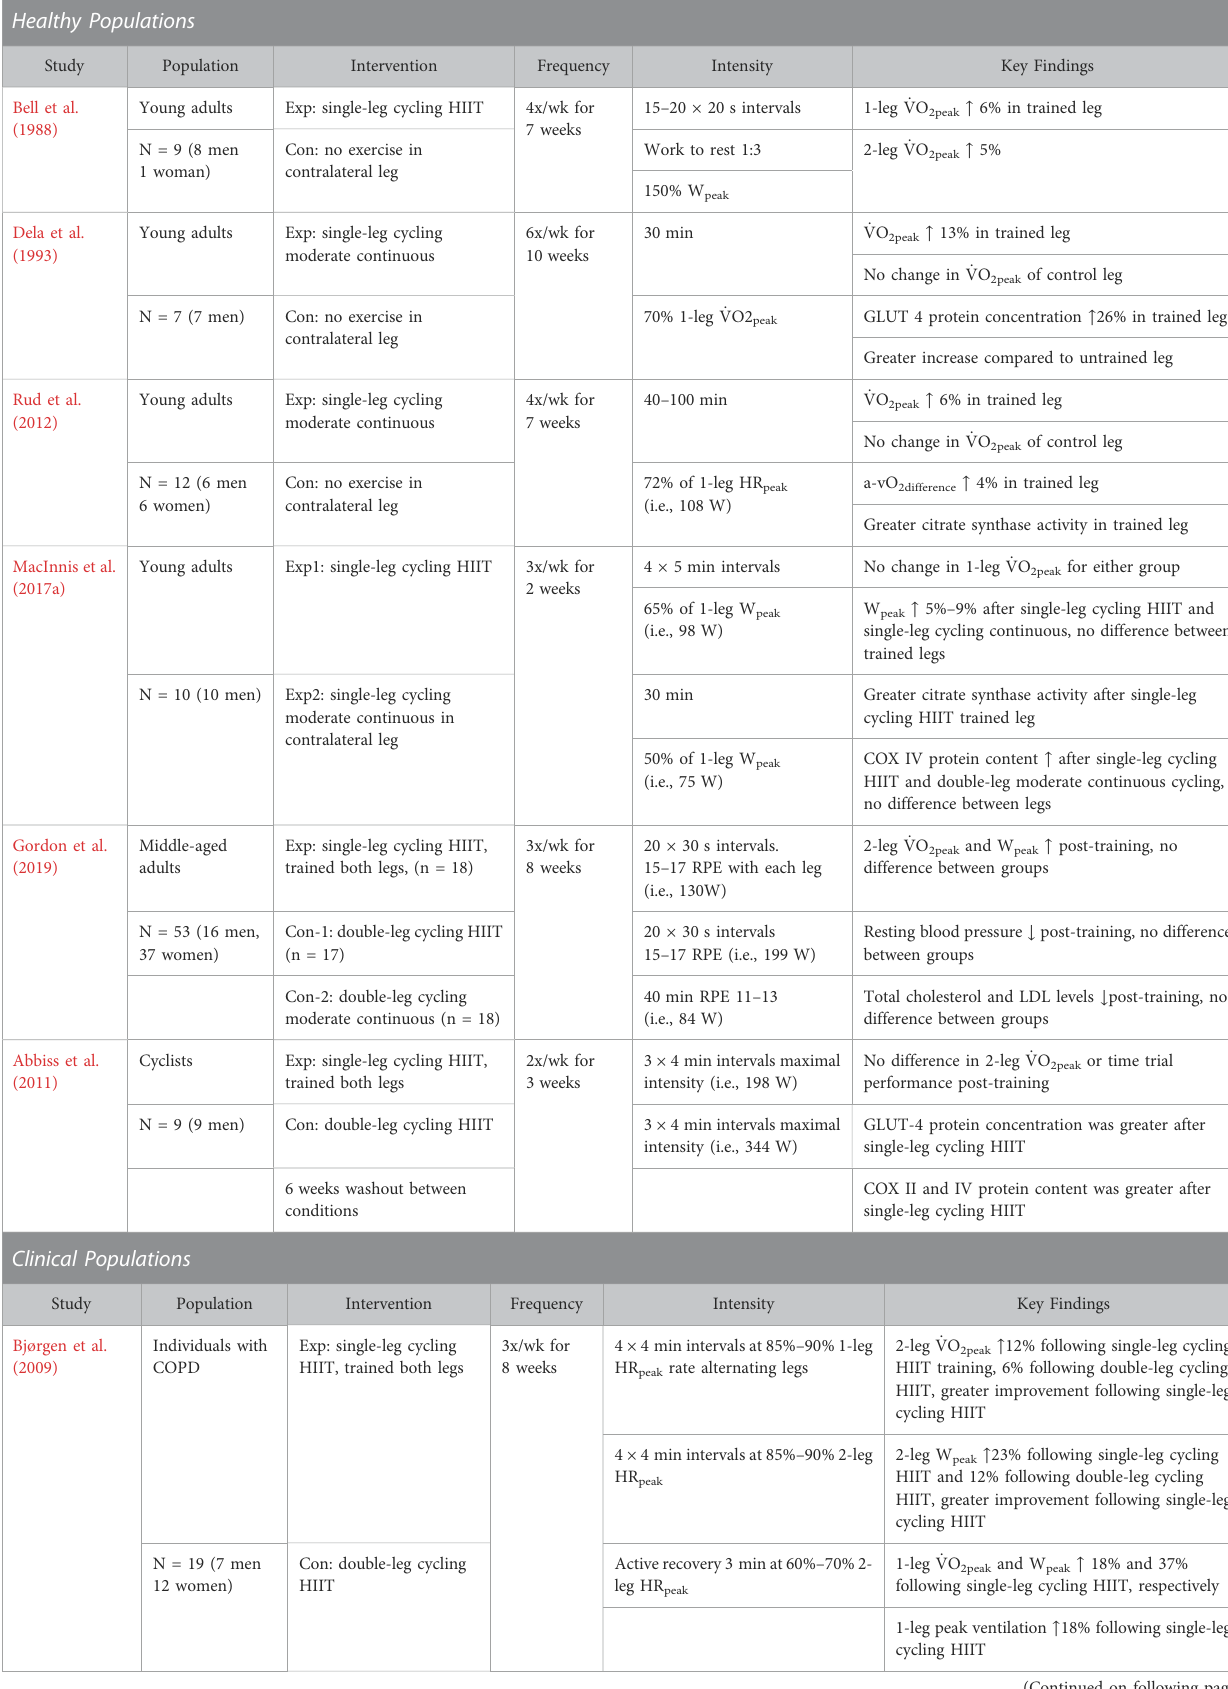
TABLE 1 Adaptations to single-leg cycling training for healthy and clinical populations. Healthy